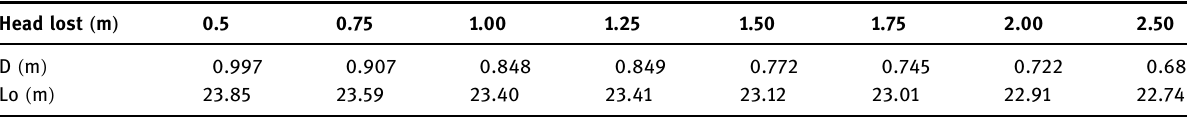
Table 7: Total head lost vs optimum diameter and safe span length